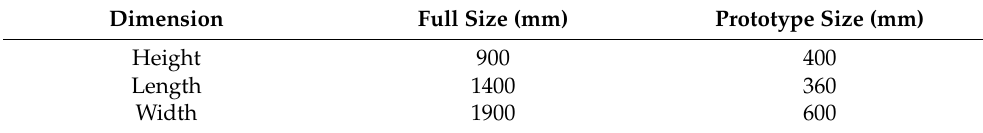
Table 8. Size comparison between full-size and prototype lamb rotisserie machine. Dimension